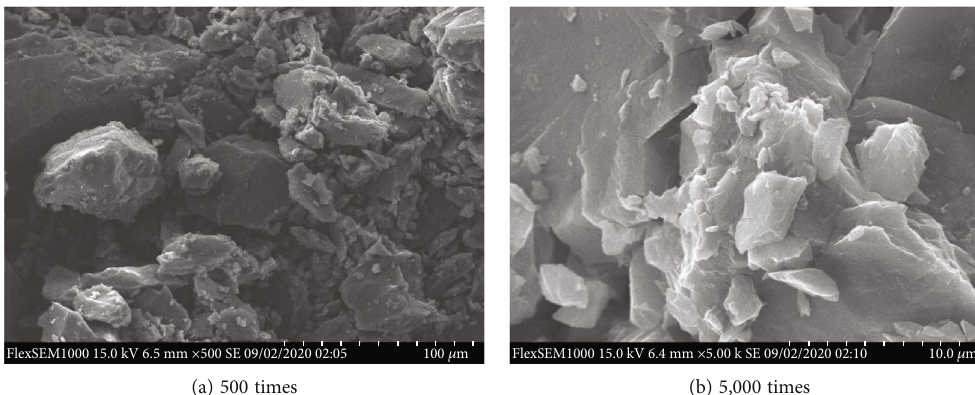
Figure 4: Microcracks in coal sample at di ff erent magni fi cation ratios.